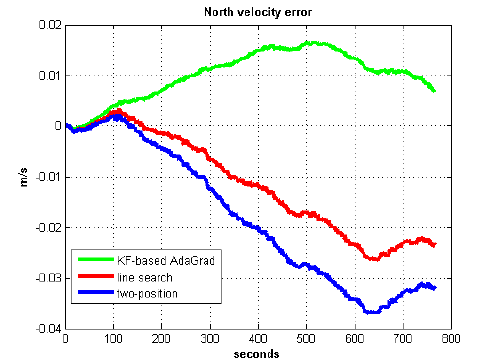
Figure 22. North velocity error in test